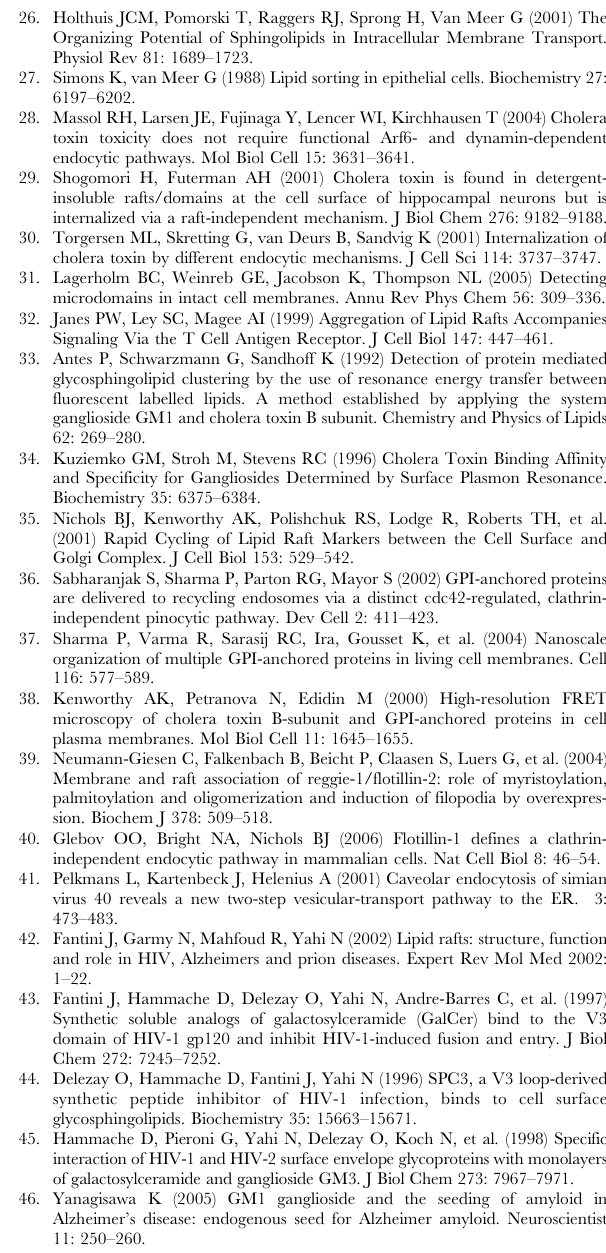
Figure S6 Uptake of SBD-TMR (incubated at 10 m M, 15 min, 25 u C) after cholesterol overloading of c6 cells with M b CD- cholesterol complexes, assessed by measurement of total intracel- lular fluorescence intensity in 25 cells per time point up to 2 h after labeling, and expressed as average fluorescence intensity per pixel (quantitation was done as in Cheng et al (Cheng et al., 2006). Uptake is slightly increased in cholesterol overloaded cells (gray bars) over control cells (black